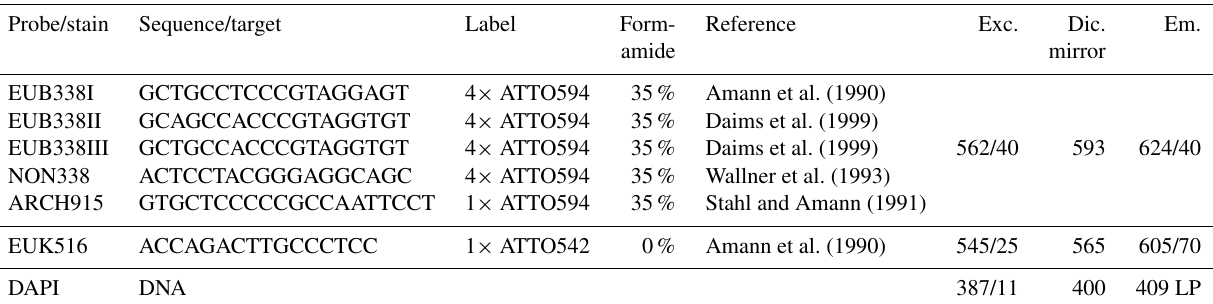
Table 1. Technical details of rRNA targeting probes and corresponding microscopic filters (excitation, Exc., dichroic mirror, Dic., and emission, Em.) used for FISH. As described in Daims et al. (1999), a mixture of EUB338 I, II, and III (referred to as EUB-mix) was applied for identification of Bacteria. By use of ARCH915, Archaea were identified, and EUK516 was applied to hybridize Eukarya. NON338 served as negative control. DAPI stains all particles containing DNA by attaching preferably to adenine- and thymine-rich sequences. For our experiments, fluorescent labels in the reddish wavelength range were chosen to avoid overlap with the autofluorescence of bioaerosols which is typically strong in the green wavelength range (Pöhlker et al., 2012). Label Form- Reference Exc. Dic. Em.